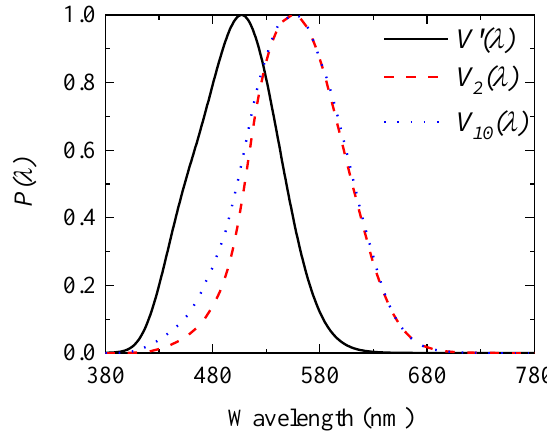
Figure 1. Spectral sensitivity curves (SSCs) for scotopic vision and photopic vision using 2- and 10-degree systems.